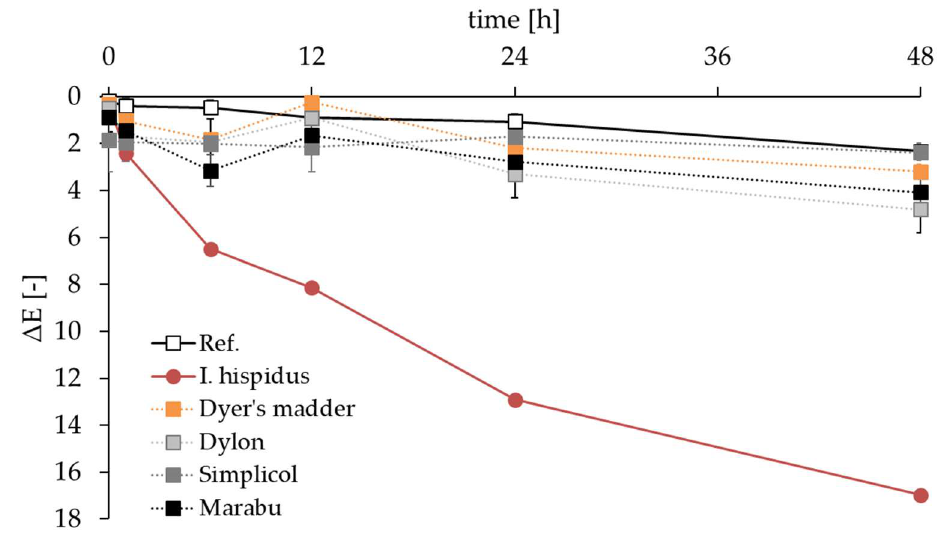
Figure 5. Comparison of the light stability of silk samples dyed with I. hispidus (red) and commercially available plant-based (Dyer’s madder, depicted in orange) and synthetic textile dyes (Dylon, Simplicol, and Marabu depicted in gray, dark gray, and black, respectively). The noncolored reference (Ref.) is shown in white squares.